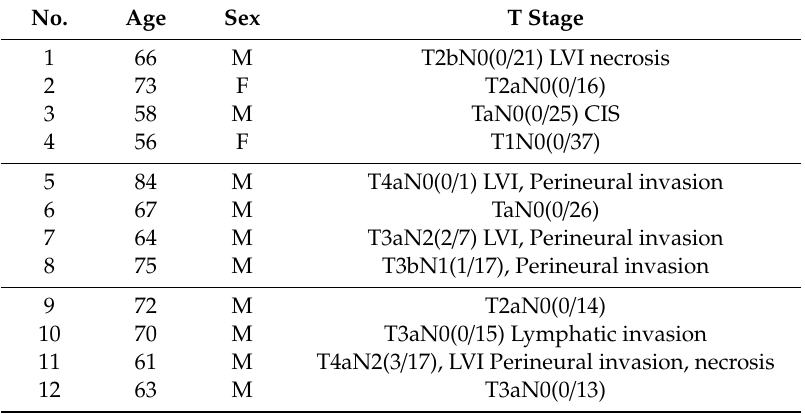
Table 1. Demographics of patients used for tissue